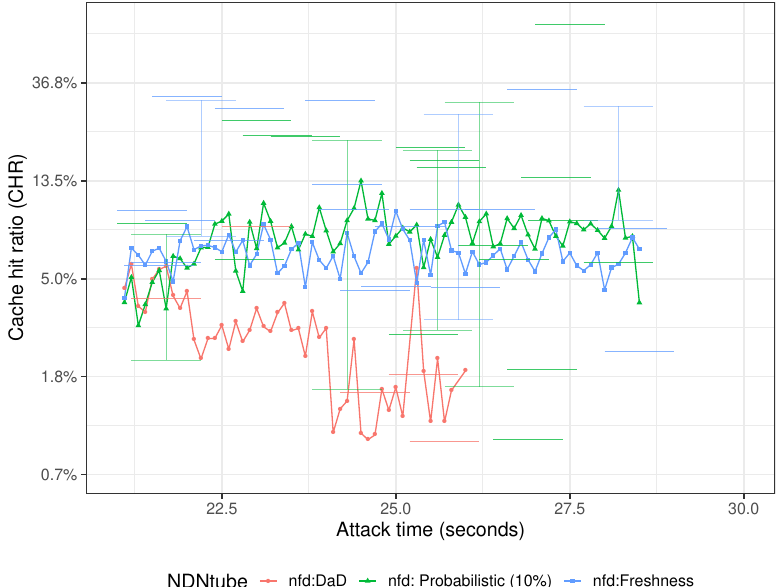
Figure 16. NDNtube attack mitigation